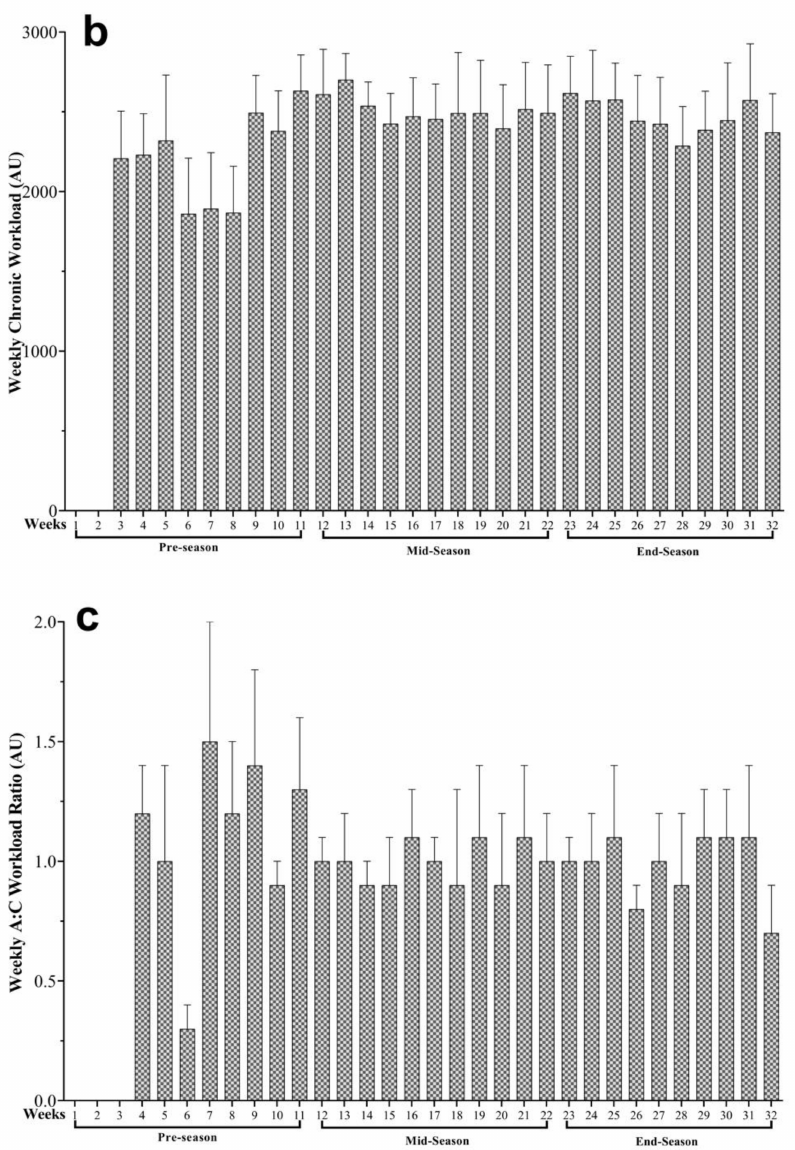
Figure 1. Descriptive statistics of ( a ) weekly average acute workload, ( b ) weekly average chronic workload, and ( c ) weekly average acute to chronic (A:C) workload ratio and their variations across the preparation season be shown in three periods (pre-, mid-, and end- season). Arbitrary units (AU). As illustrated in Figure 2, the wTM and wTS variations across the full PS and their different periods. The highest and lowest workloads were wTM (W11 = 2.89 ± 1.80 and W6 = 0.49 ± 0.18 AU) and wTS (W11 = 9159.75 ± 7794.16 and W6 = 408.98 ± 122.34 AU),